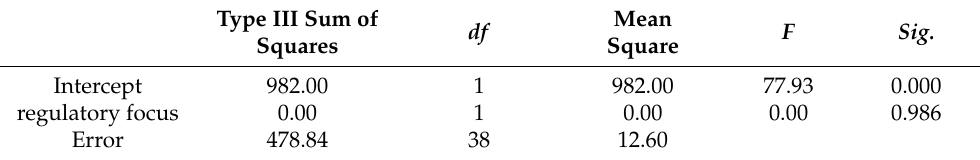
Table 11. Tests of Between-Subjects Effects of P2 amplitude (regulatory focus).